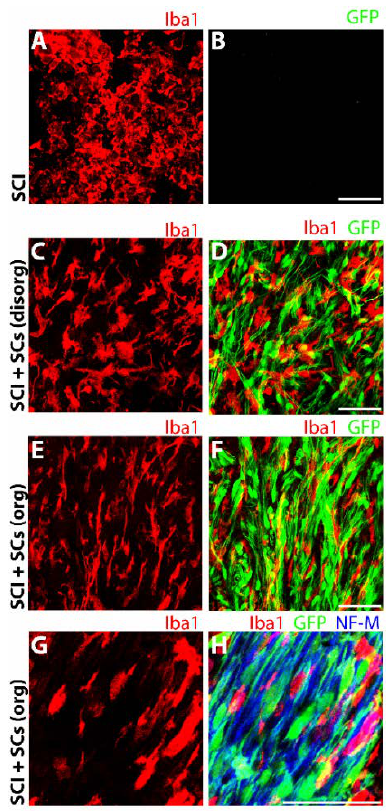
Figure 9. Pronounced morphological changes occur in Iba1 (red) microglia and macrophages after SCI in the presence of transplanted SCs (green). Microglia and macrophages immunoreactive for Iba1 exhibited a rounded, amoeboid morphology in the lesion and perilesional regions of SCI controls ( A , B ). In contrast, in EGFP-SC-transplanted animals, Iba1 immune cells displayed either a ramified, multipolar phenotype ( C , D ), commonly associated with resting or surveillant cells, or an elongated, rod-shaped form that aligned in parallel to that of SCs and axons (blue) ( E – H ). Images were acquired at 60× objective magnification for ( A – F ) and at 140× for ( G , H ). Scale bar = 50 μm.